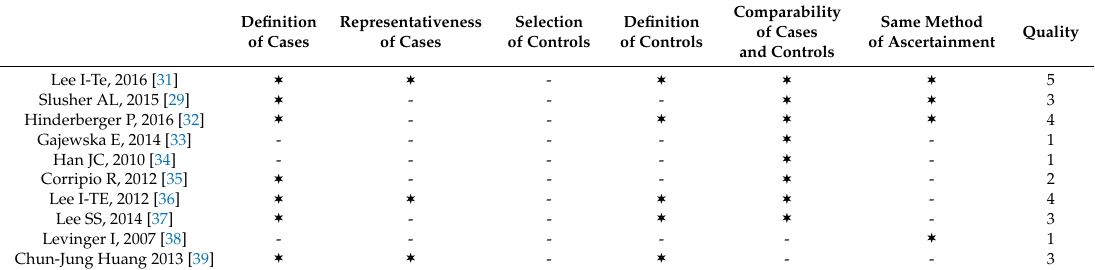
Table 3. Quality assessment (Newcastle–Ottawa scale) of 10 studies.